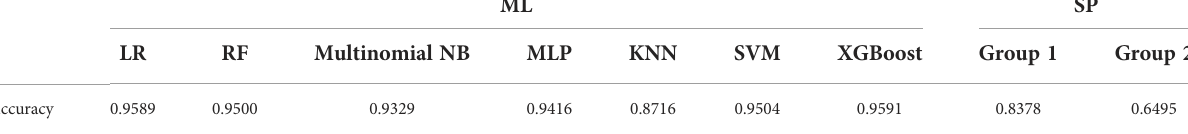
TABLE 4 The comparation of results based on machine learning model and string pattern search